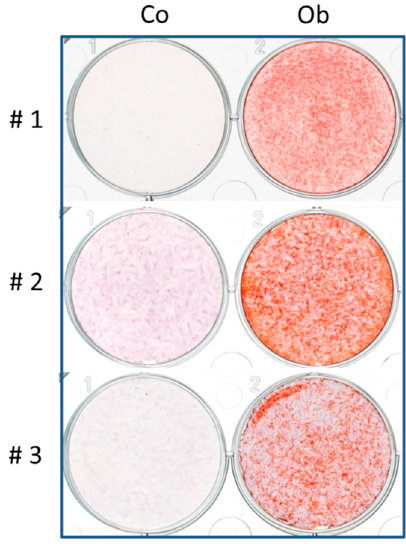
Figure 1. Alizarin staining of undifferentiated (co) and osteogenically differentiated (ob, 21 days) jaw periosteal cells (JPCs) derived from the 3 donors (#1, 2, 3) used for the following co-culture experiments.